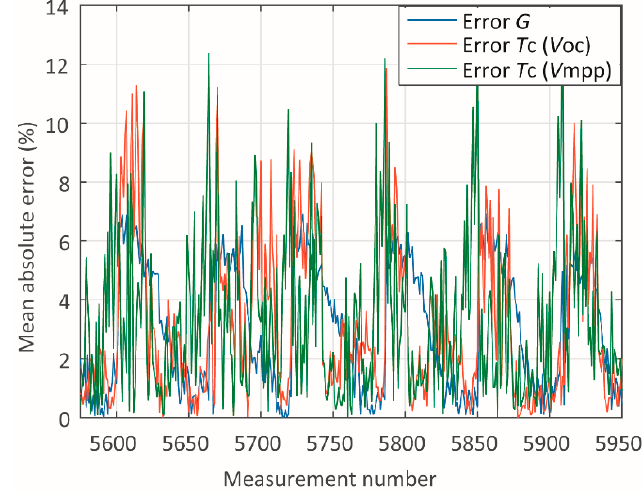
Figure 7. Absolute errors during clear-sky days.